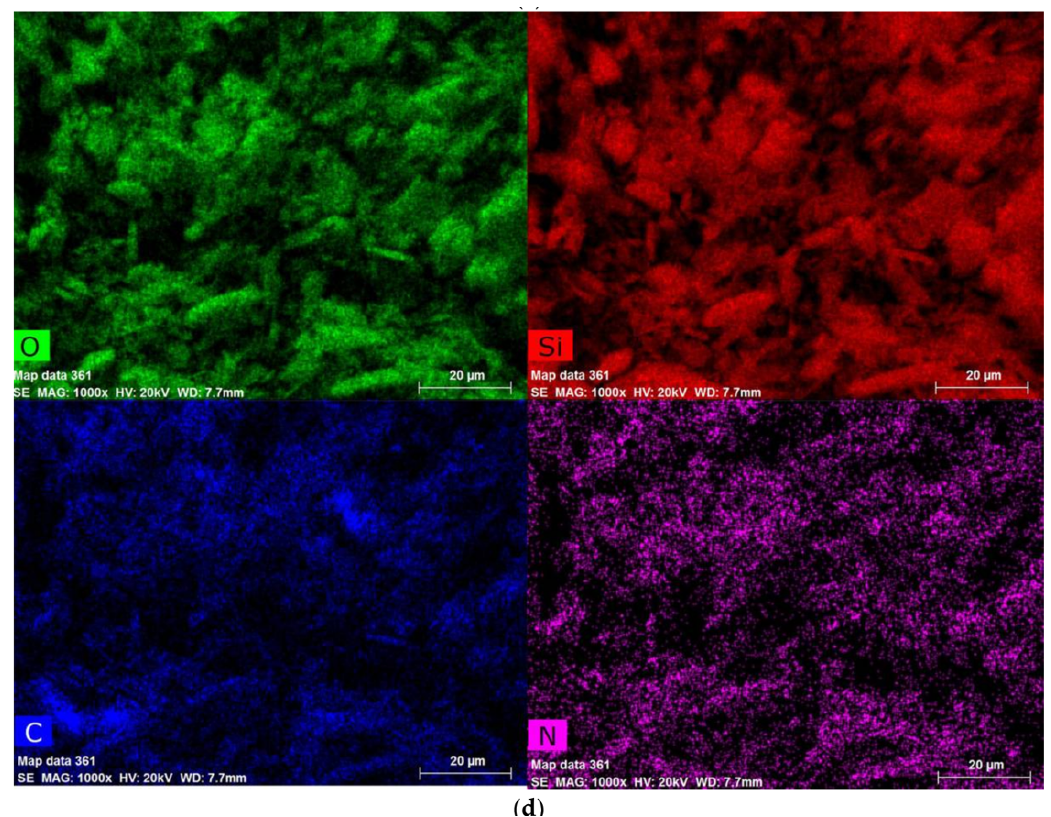
Figure 7. Elements analysis by mapping in SEM: ( a ) a-Verm; ( b ) OVerm; ( c ) PAM/OVerm; ( d ) g-PAM/OVerm. Table 1. Elemental Analysis of a-Verm, OVerm, PAM/OVerm and g-PAM/OVerm by EDS. Samples Elements a-Verm OVerm PAM/OVerm g-PAM/OVerm Elements content (weight